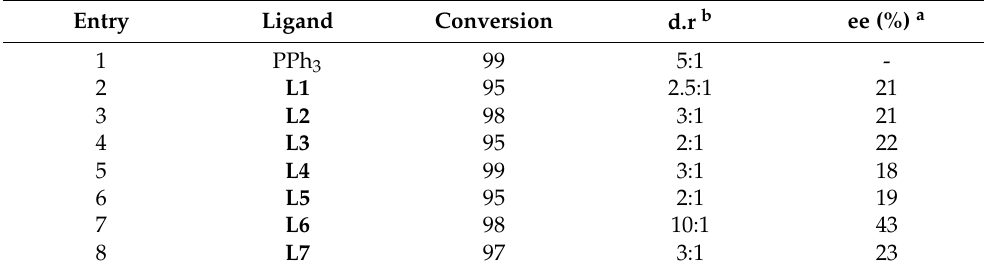
Table 2. Effect of chiral ligands on the intramolecular interrupted HAM reaction using ( 3f ) as a model